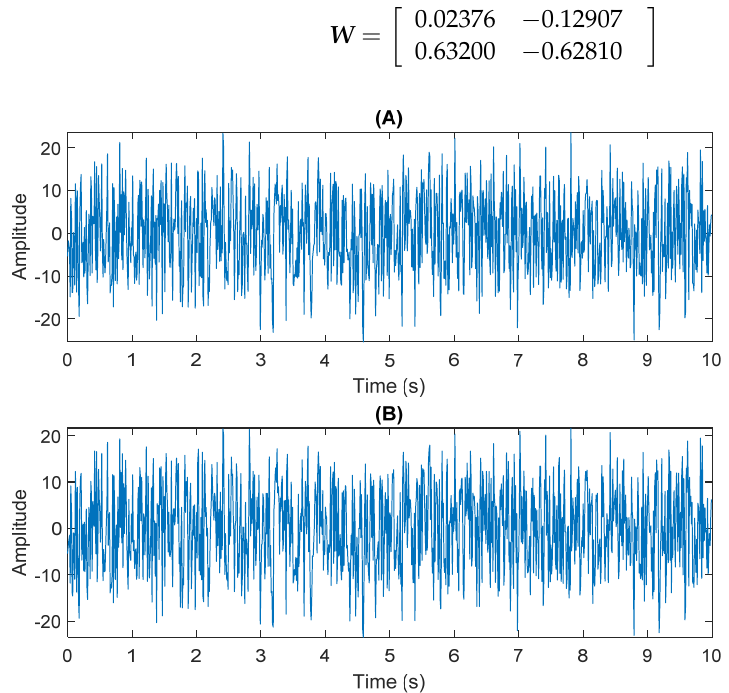
Figure 2. The numerical simulation of data received by two sensors: ( A ) In Equation (29) the sensor signal x1. ( B ) In Equa- tion (29) the sensor signal x2.